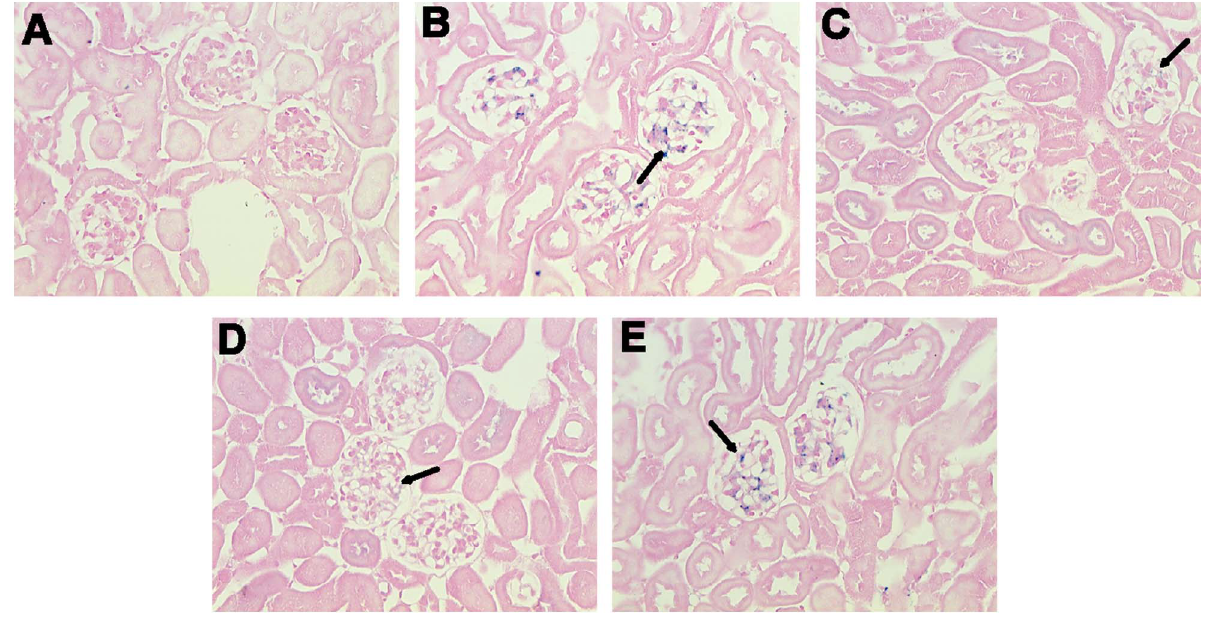
Figure 3. Effects of Danshen injection on iron deposition in kidneys. Representative microscopic photographs of kidneys stained with Prussian blue (magnification 400 6 ). Samples were obtained from the control group (A), iron overload (B), DFO (C), H-Danshen (D) and L-Danshen (E) groups. Black arrows indicate iron deposits in glomerular cells.